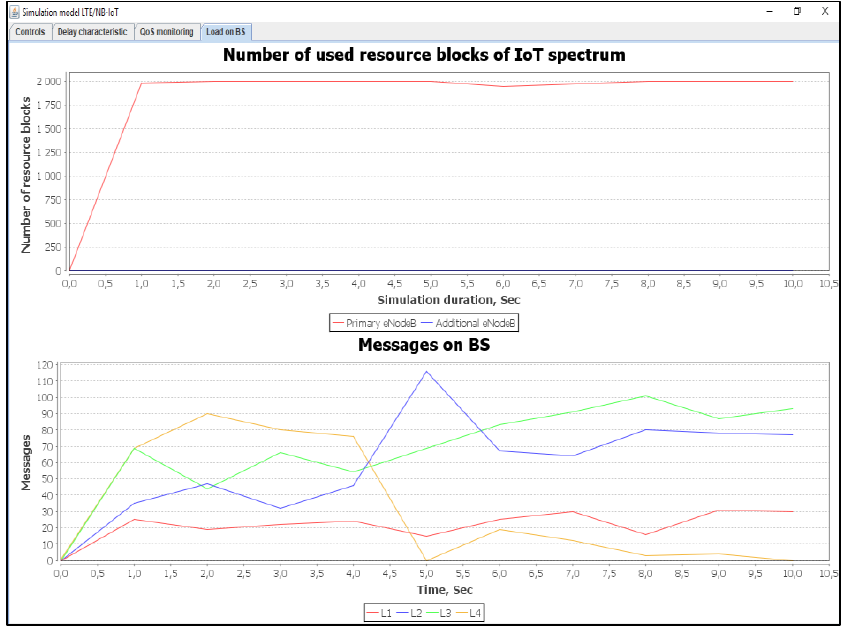
Figure 24. Used IoT spectrum resource blocks and transmitted messages ratio with different priorities (average load of IoT controller ρ = 100%).